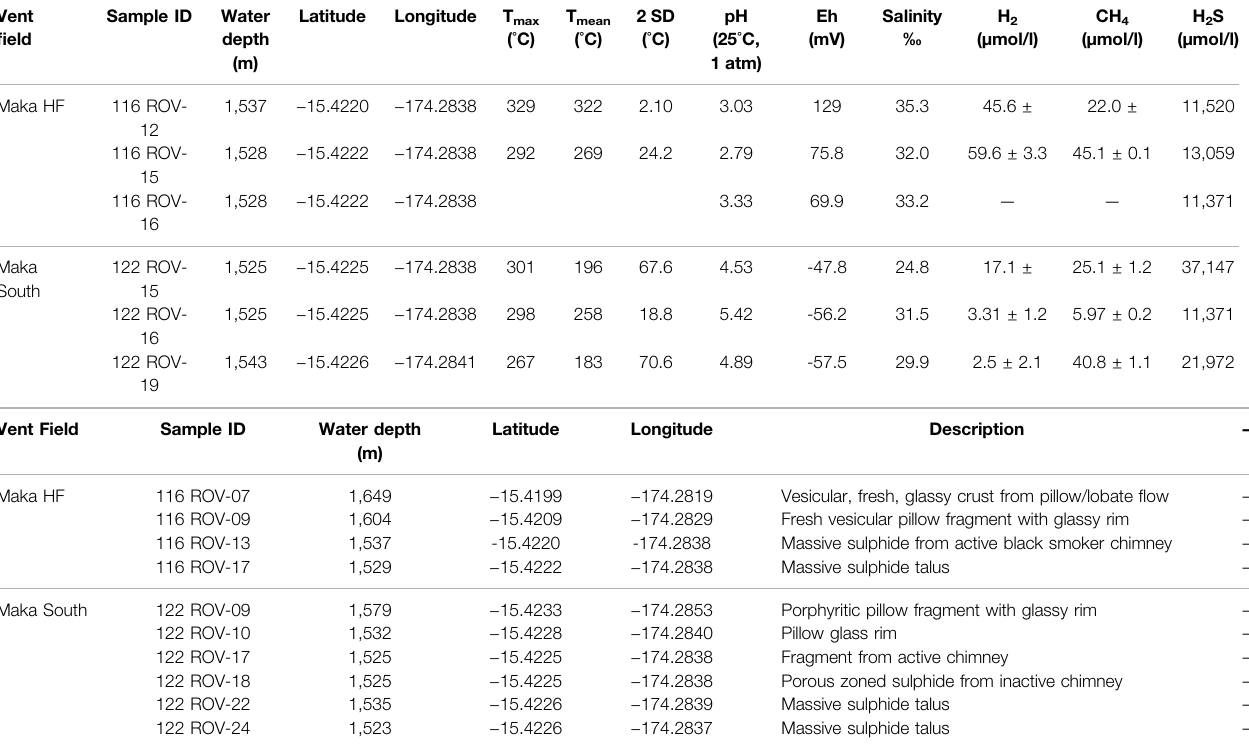
TABLE 1 | Overview of collected fl uid and sulphide samples with maximum fl uid temperatures and on-board measured parameters. Vent Sample fi eld